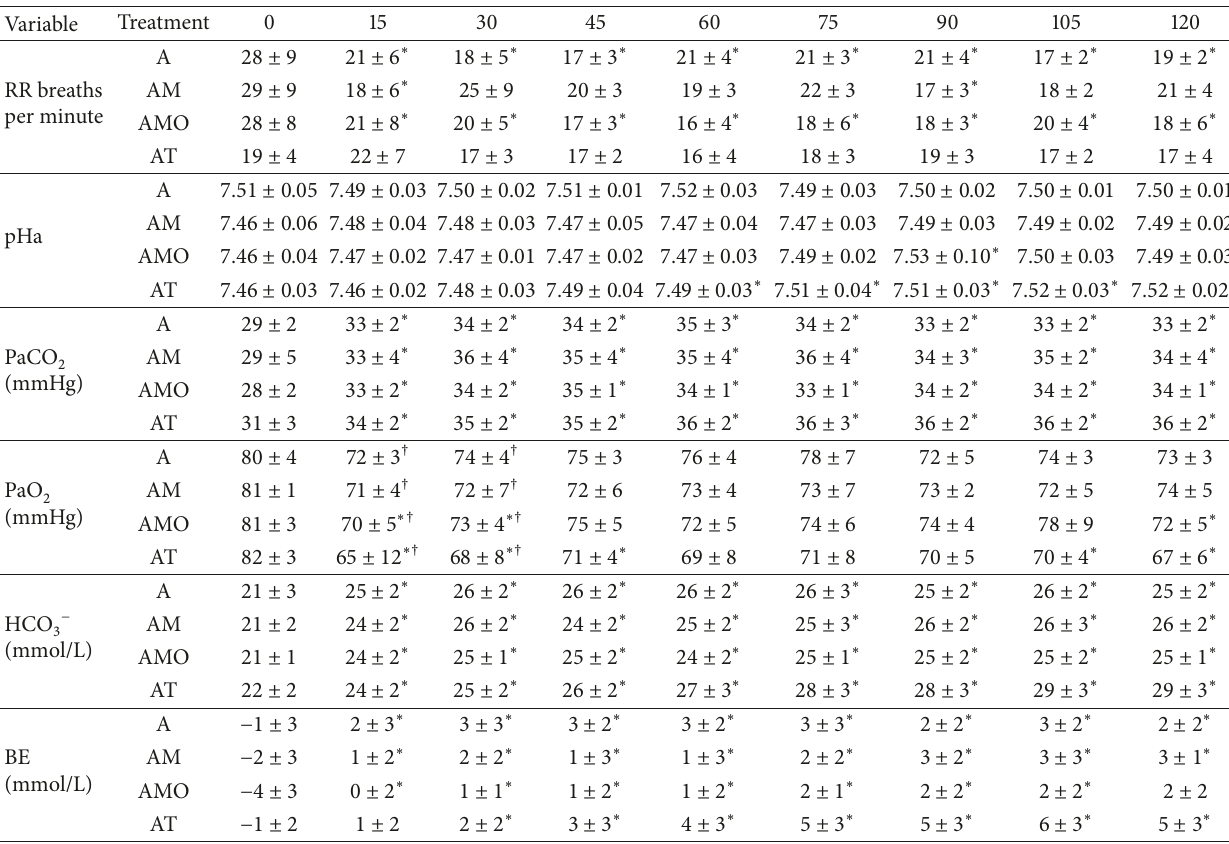
Table 2: Mean ± standard deviation of respiratory rate (RR) arterial pH (pHa), partial arterial pressure of carbon dioxide (PaCO 2 ), partial arterial pressure of oxygen (PaO 2 ), bicarbonate (HCO 3− ), and base excess (BD) in six ewes sedated with acepromazine alone (A), acepromazine-methadone (AM), acepromazine-morphine (AMO), or acepromazine-tramadol